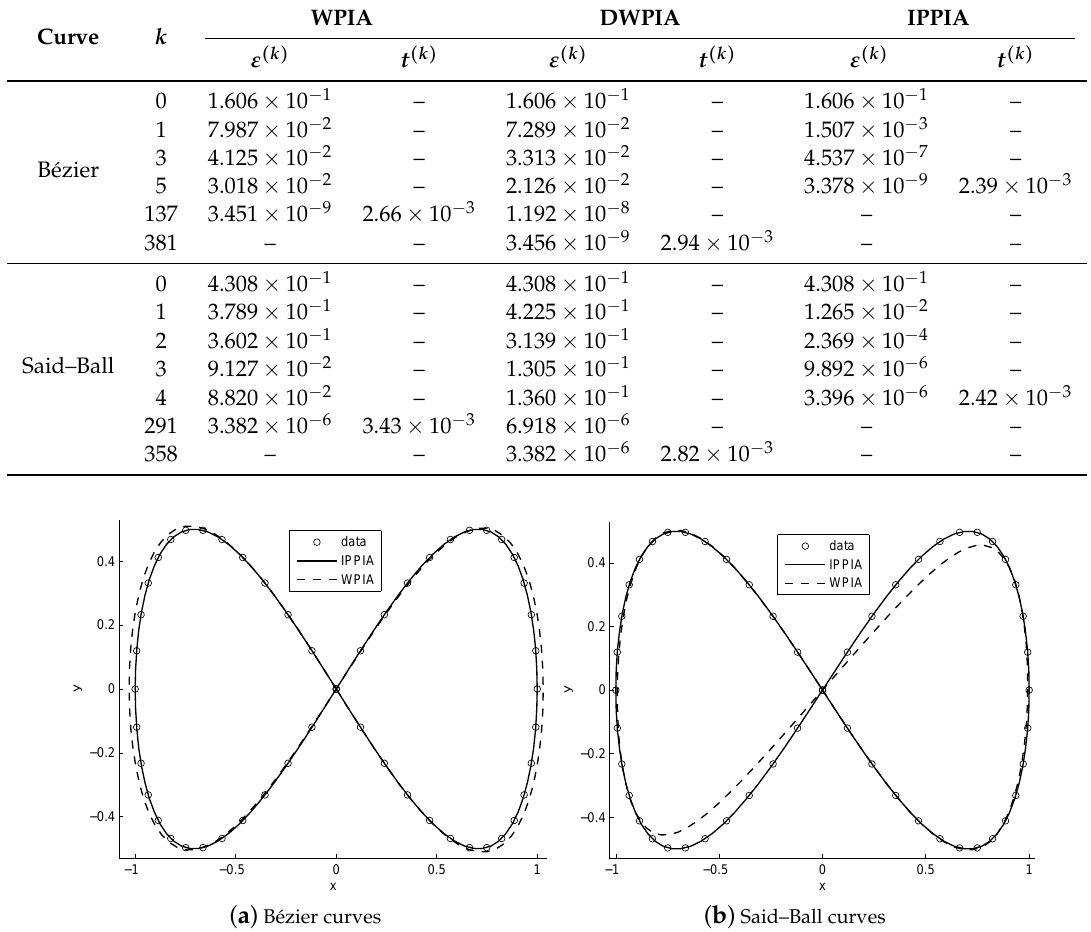
Figure 7. Approximations to 53 points sampled from the lemniscate of Gerono at the fifth iteration. Table 7. Numerical results when fitting 53 points sampled from the helix.